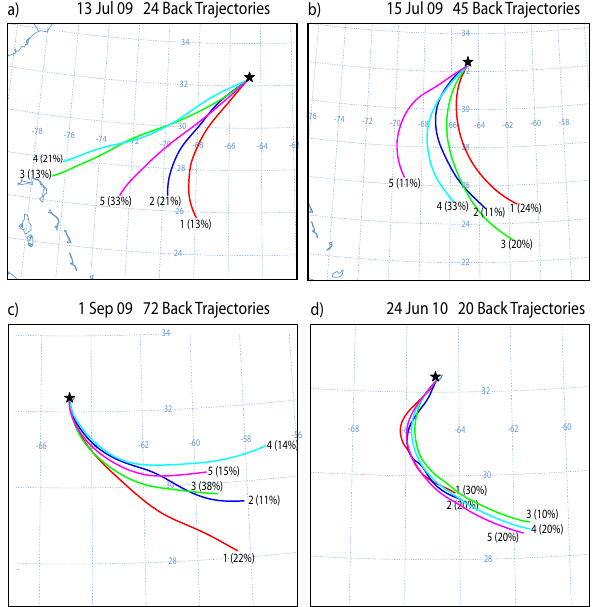
Fig. 1. (a–d) Warm season 36h back trajectories clustered from 100m, 2000m, and 5000m starting every hour during the rain event for the four warm season events. The number of back trajectories clustered is therefore dependent on the length of the rain event. The trajectories are numbered 1–5 and labeled with the percentage of total trajectories (shown in each figure) represented in that mean trajectory. The starting location for the back trajectories is the island of Bermuda 32.27 ◦ N 64.87 ◦ W (black star).